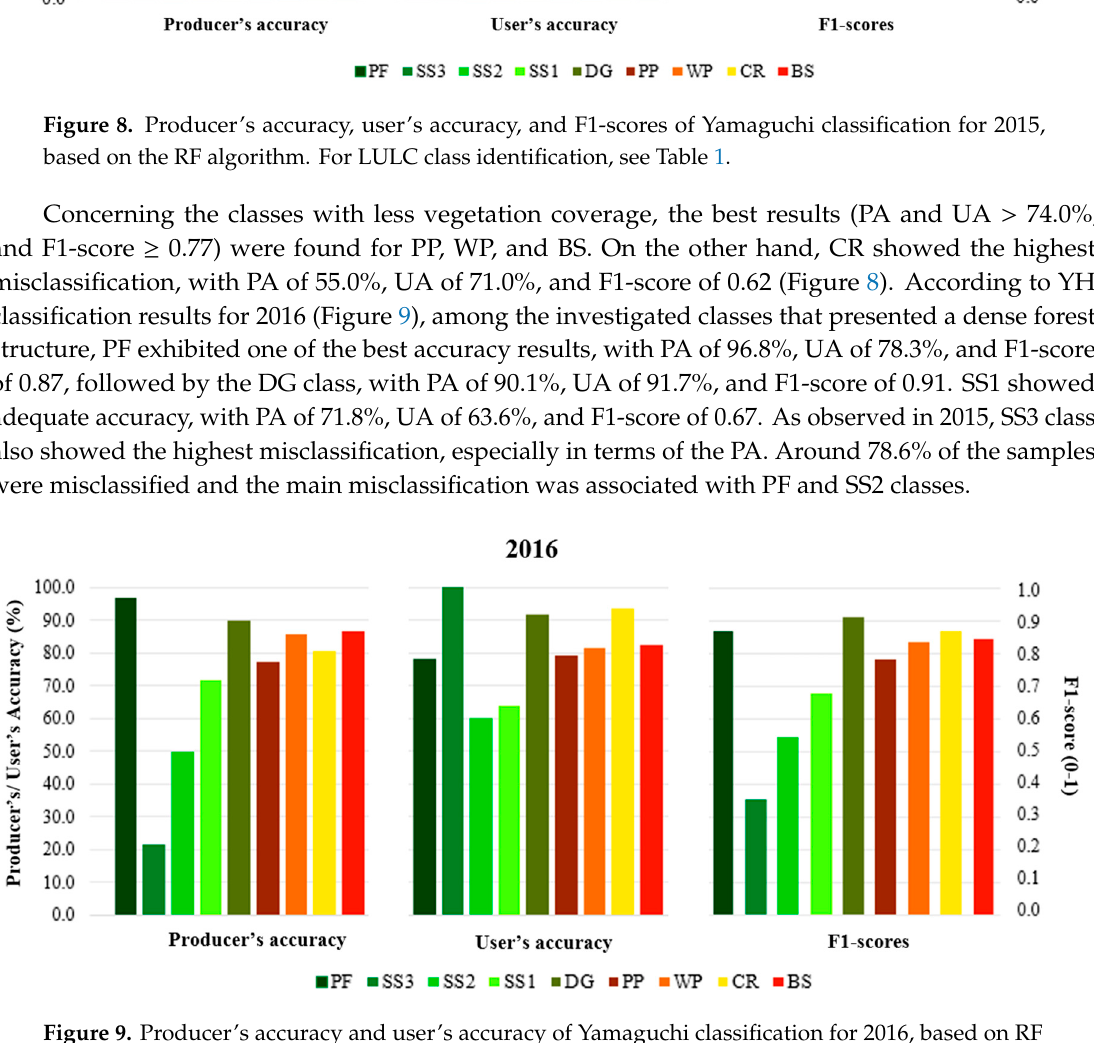
Figure 9. Producer’s accuracy and user’s accuracy of Yamaguchi classification for 2016, based on RF algorithm. For LULC class identification, see Table 1.